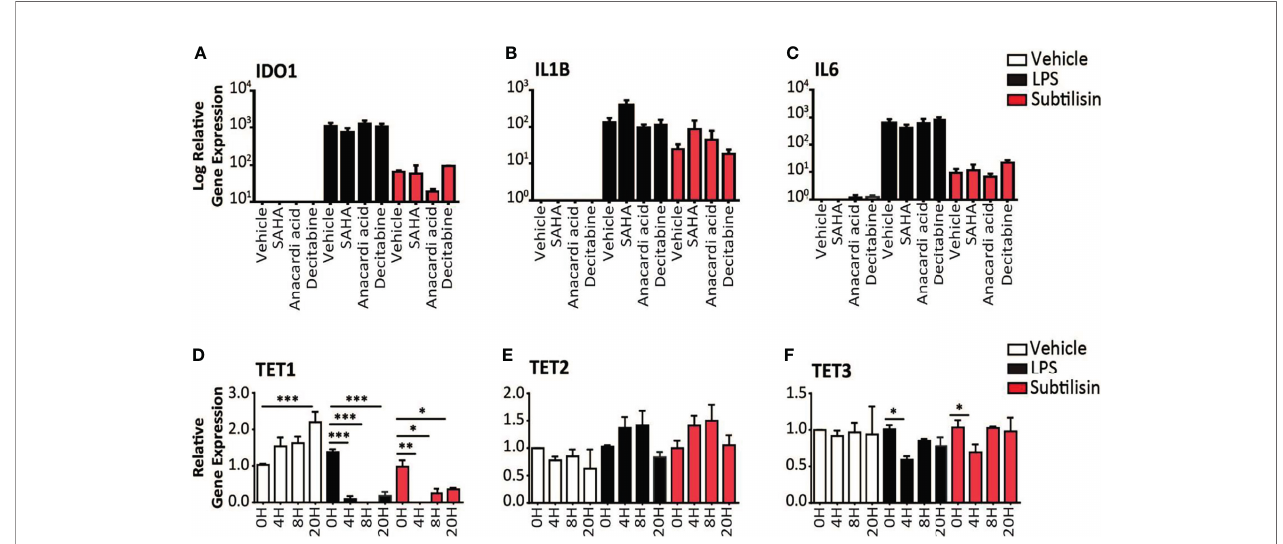
FIGURE 4 | Epigenetic modulators and gene expression. (A – C) Charts of the gene expression (logarithmic axis) relative to baseline of (A) IDO1 , (B) IL1B and (C) IL6 in MDMs exposed to vehicle (open bars), 10 ng/mL LPS (black bars) or 20 nM subtilisin (red/shaded bars). The data shows the effects of 10 m M SAHA (an inhibitor of histone deacetylase), 10 m M anacardic acid (an inhibitor of histone acetylase) and 2 m M decitabine (an inhibitor or DNA methyltransferase). (D – F) Logarithmic expression relative to baseline of TET1 (D) , TET2 (E) and TET3 (F) in cells exposed to vehicle (open bars), 10 ng/mL LPS (black bars) or 20 nM subtilisin (red/shaded bars). Charts show the mean ± s.e.m. (n ≧ 3 donors). *P < 0.05, **P < 0.01; ***P <